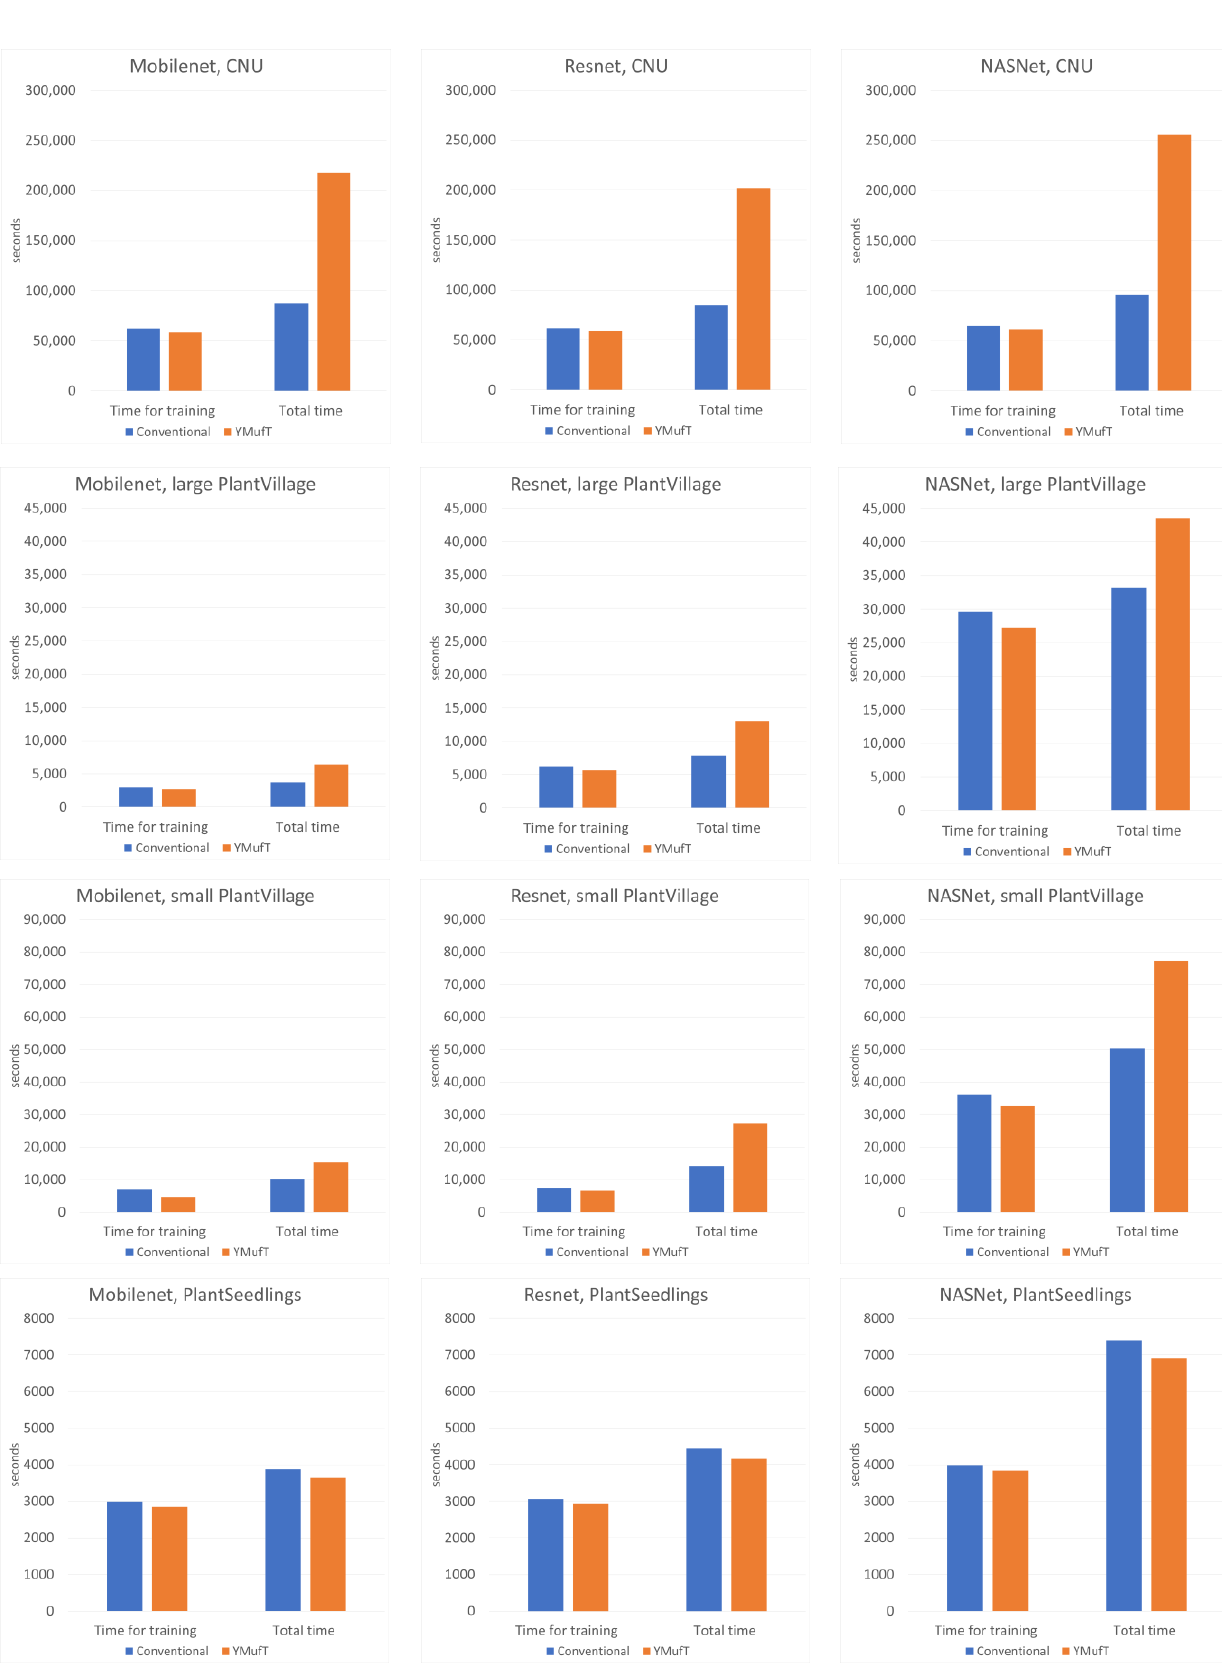
Figure 9. Total validation time of each of the models on the four different datasets.